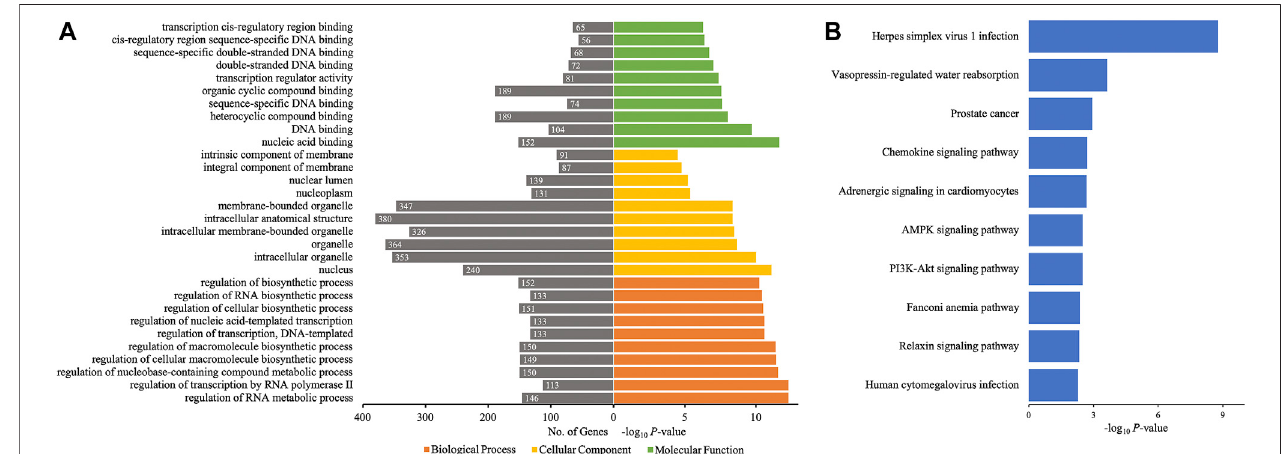
FIGURE6| GOannotationsandKEGGpathwayanalysesfortargetgenesofthe10differentiallyquanti fi edcircRNAsveri fi edbyqRT-PCR. (A) GOannotations.The GO analysis categorized the mRNAs into different groups under the theme of biological process, cellular component, and molecular function. The gene count for each GO category is listed on the left. (B) Top 10 KEGG pathways. The vertical axis indicates the pathway category, and the horizontal axis indicates the − log 10 p -value of a pathway (Fisher ’ s exact test).